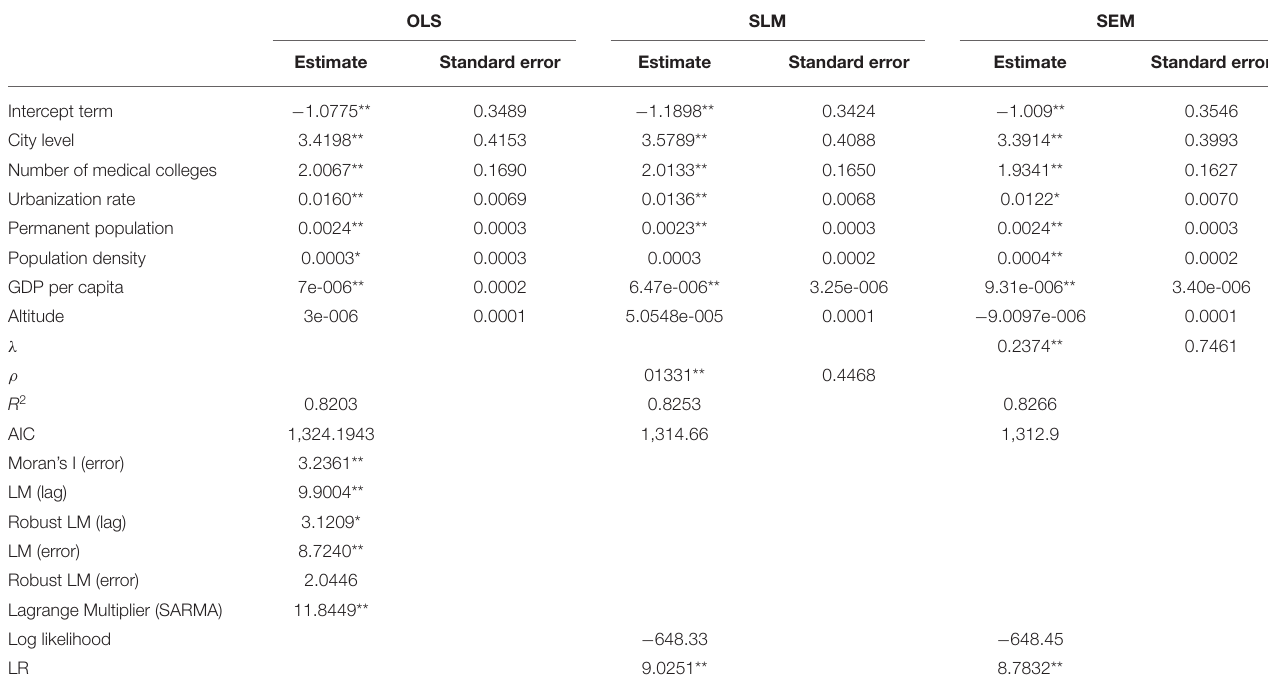
TABLE 4 | Regression estimation results of three models.